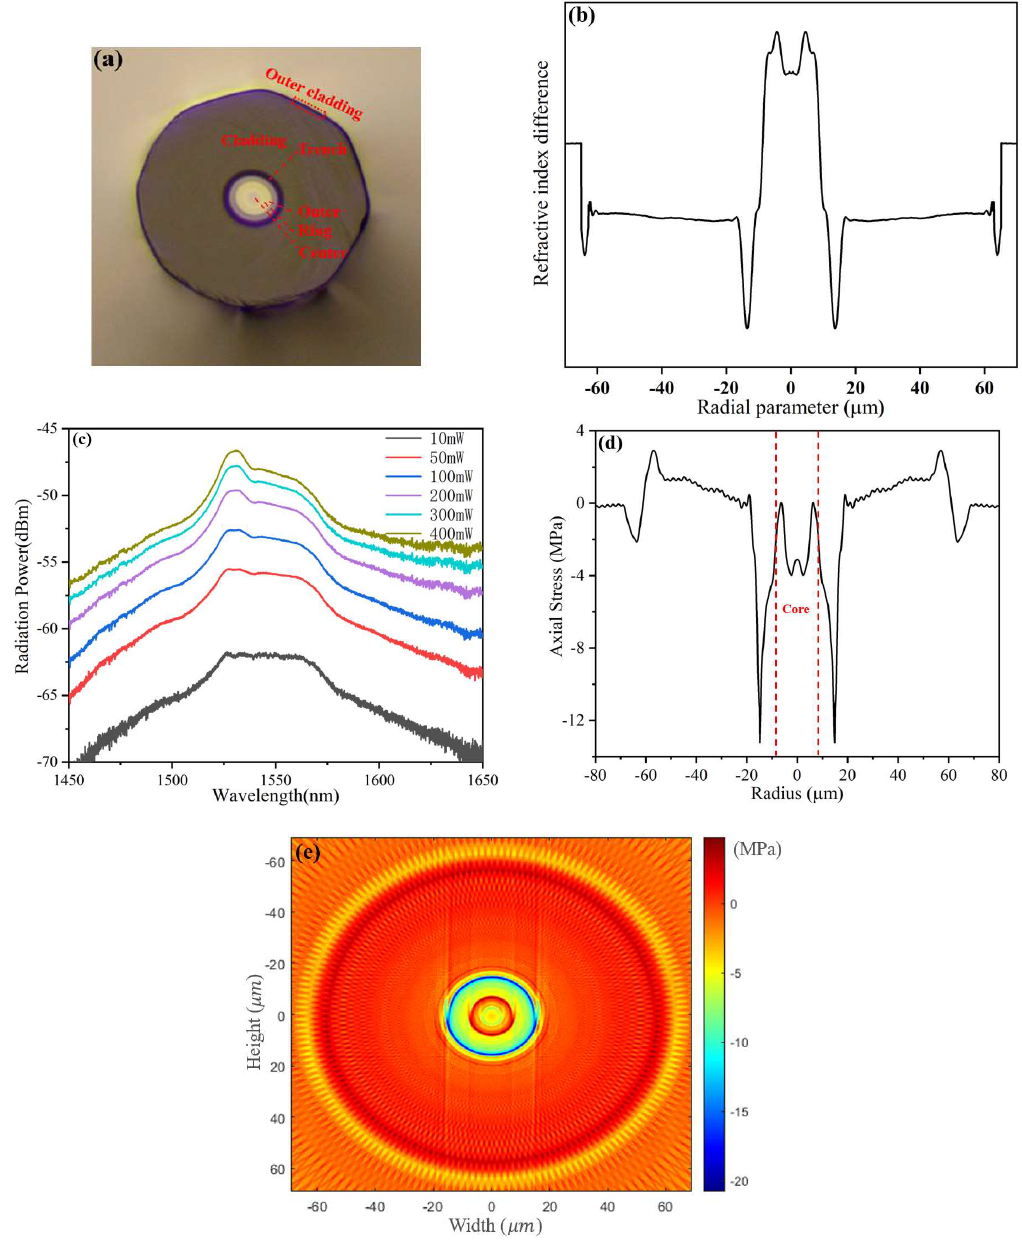
Figure 7. ( a ) Cross section, ( b ) RI profile, ( c ) spontaneous emission spectrum, and ( d ) one-dimensional residual stress and ( e ) two-dimensional residual stress distributions on the cross section of FM-EDF-HAER.